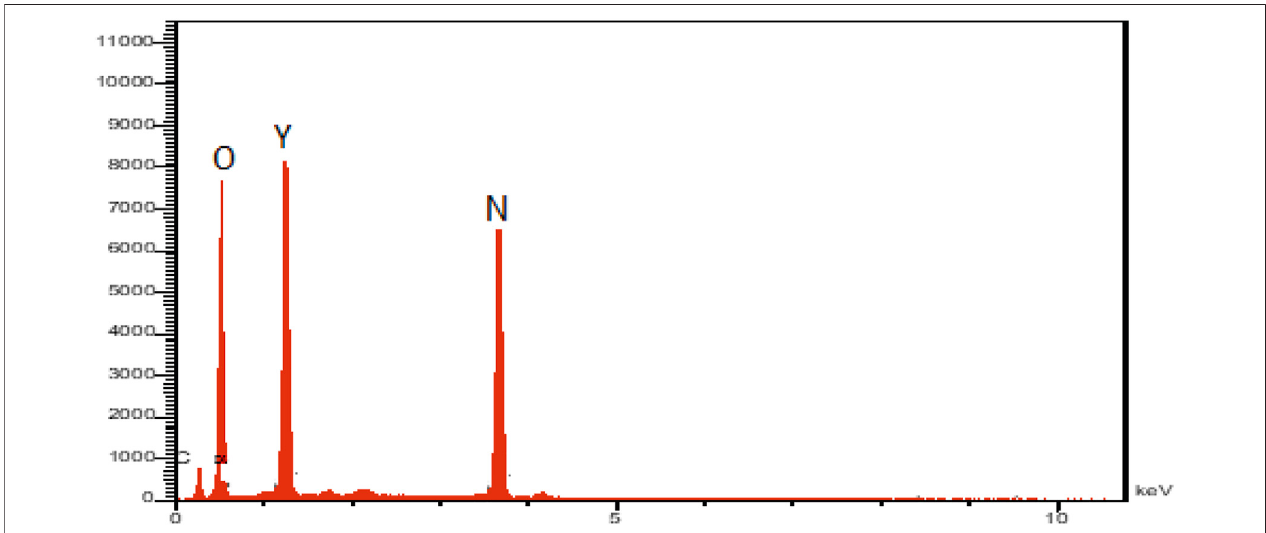
FIGURE 4 | EDX elemental analysis of Y-MOF synthesized under the optimal condition of the microwave route.